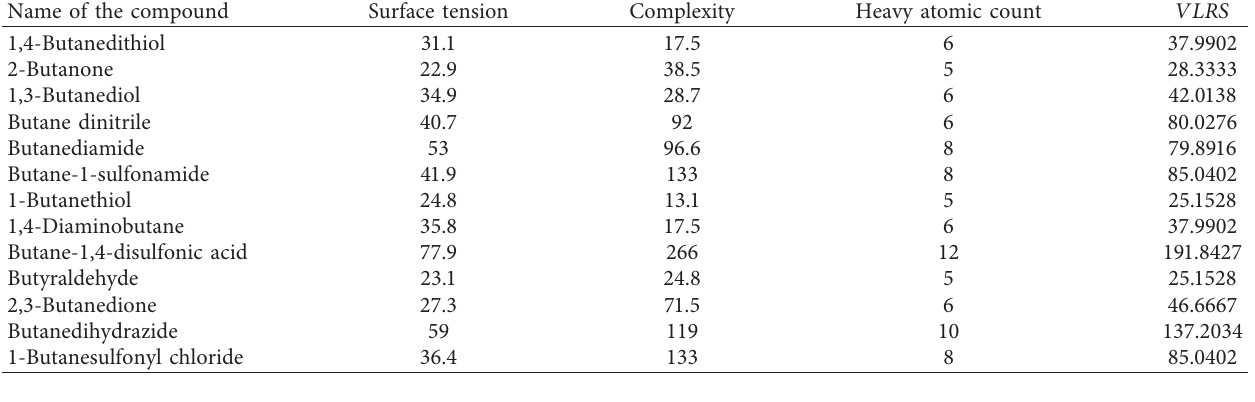
Table 1: Correlation of VLRS index and some properties of Butane derivatives.